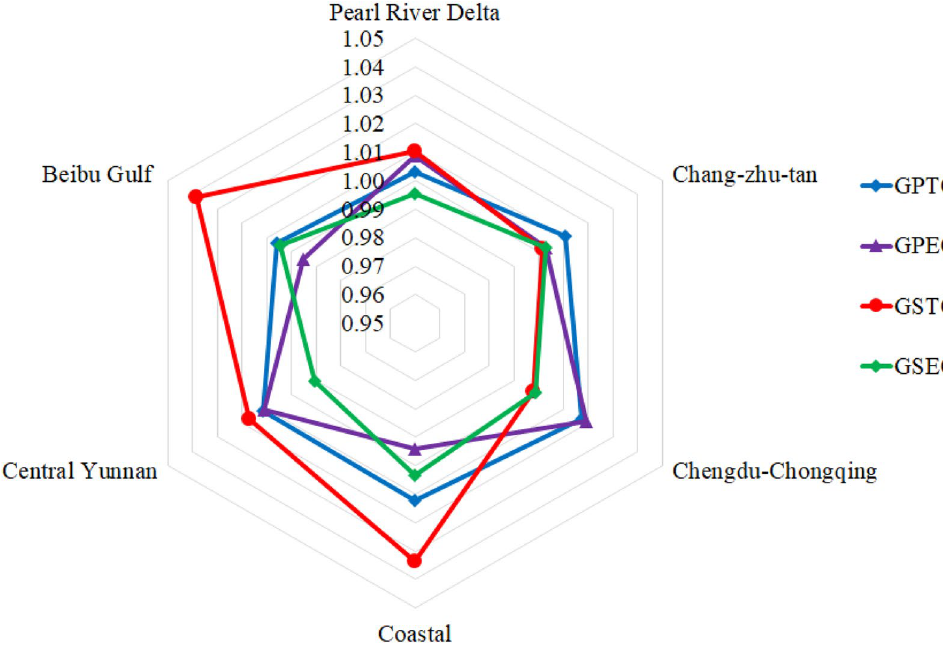
Figure 2. Decomposition of green total factor productivity changes in sub-city groups (2006–2015